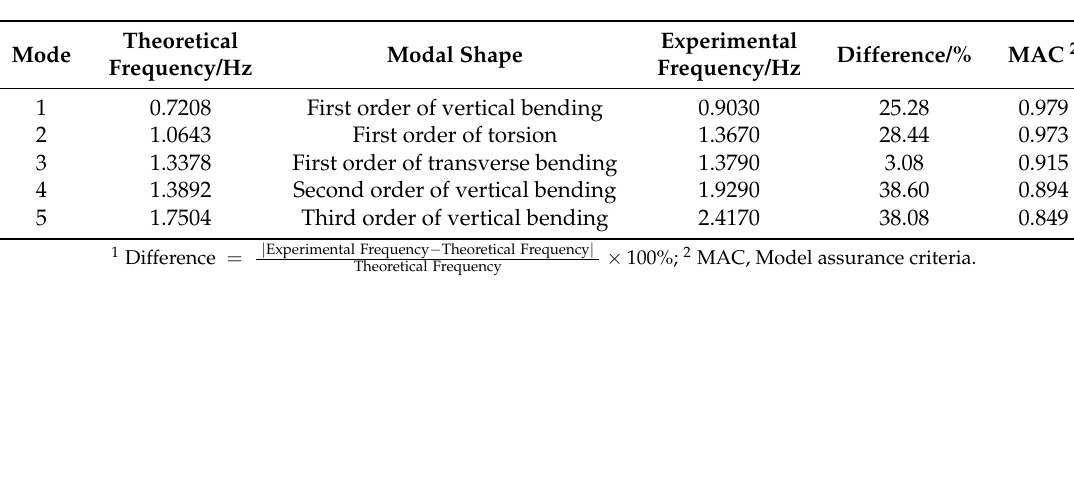
Table 3. Detail dynamic characteristics of main girder from theoretical and experimental analysis 1